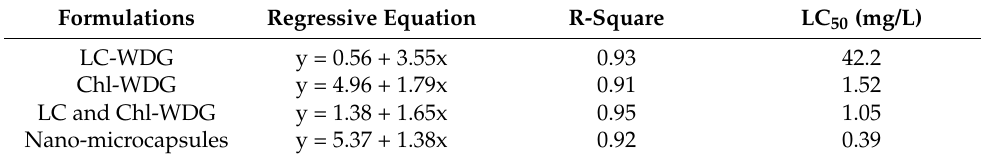
Table 2. Toxicities of the nano-microcapsules and commercially available water-dispersible granules. Formulations Regressive Equation R-Square LC 50 (mg/L) LC-WDG y = 0.56 + 3.55x 0.93 42.2 Chl-WDG y = 4.96 + 1.79x 0.91 1.52 LC and Chl-WDG y = 1.38 + 1.65x 0.95 1.05